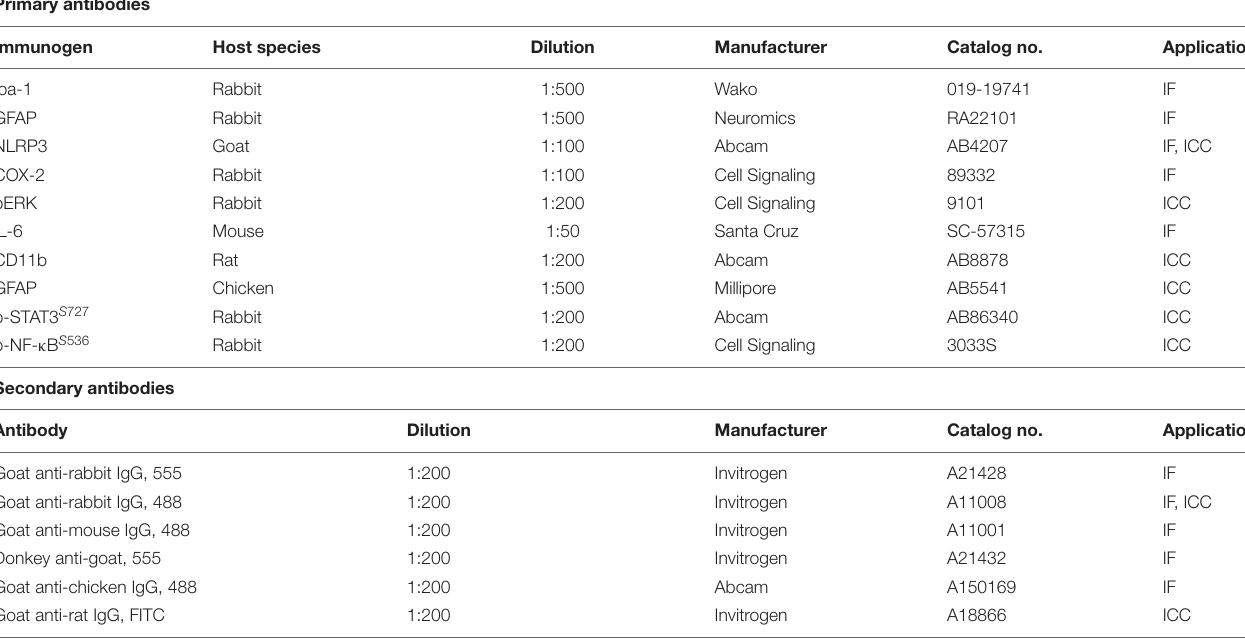
TABLE 1 | List of antibodies used for Immunofluorescence Staining (IF) or immunocytochemistry (ICC). Primary antibodies